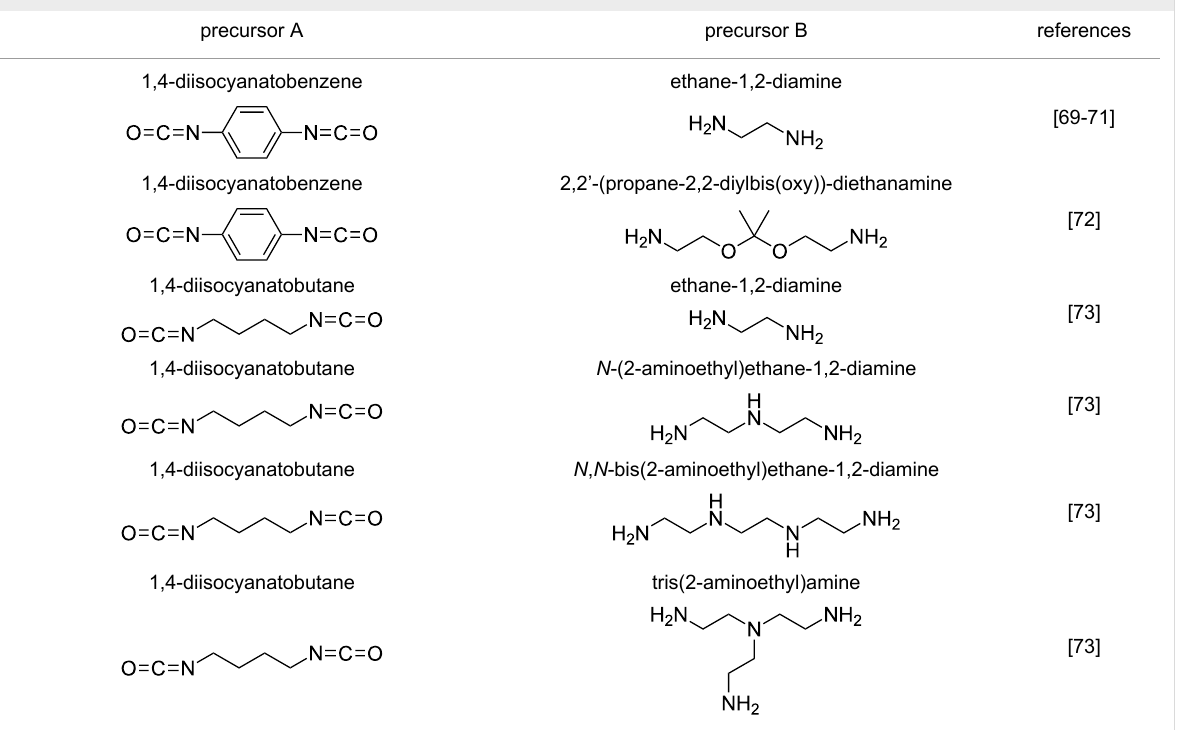
Table 6: Precursors used to deposit polyurea thin